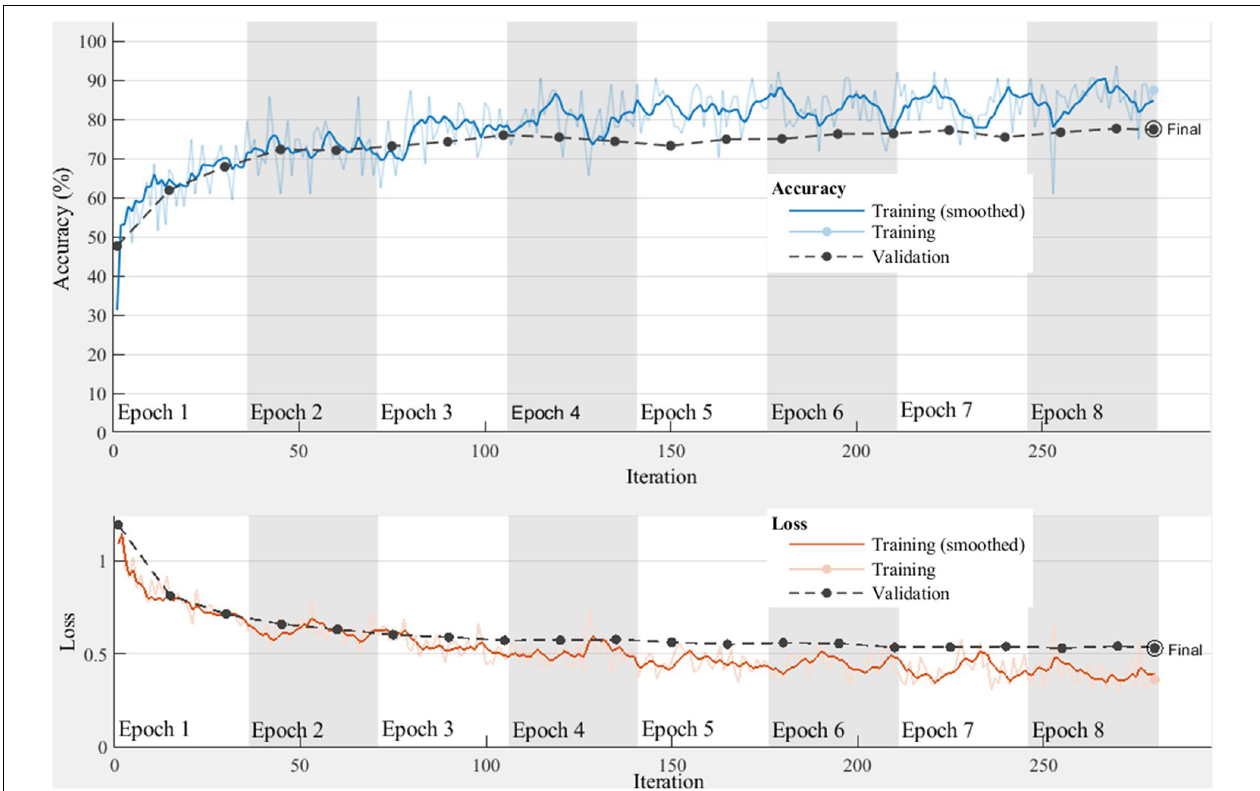
FIGURE 4 | Accuracy and loss histories of the TS-based CNN model. For both training and validation datasets, the loss histories are decreasing, indicating that the CNN model is properly trained without overfitting. One epoch means all training samples are fed to the CNN model once before the next training iteration starts.